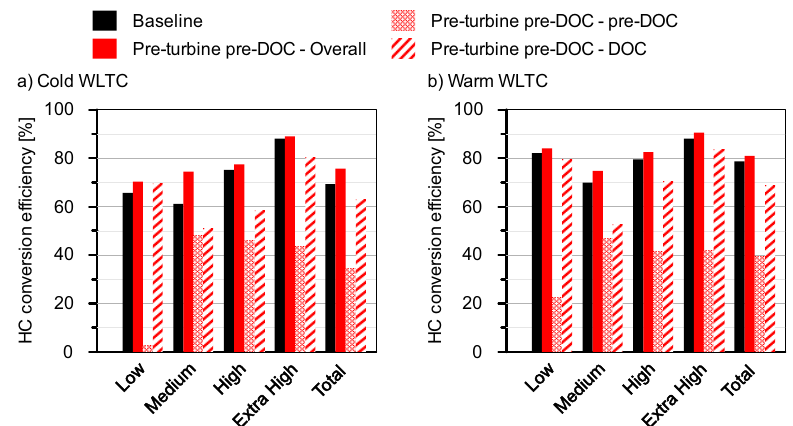
Figure 12. HC conversion efficiency in each WLTC phase in ( a ) cold and ( b ) warm tests: baseline (DOC) and pre-turbine pre-DOC (overall and contributions from pre-DOC and DOC)